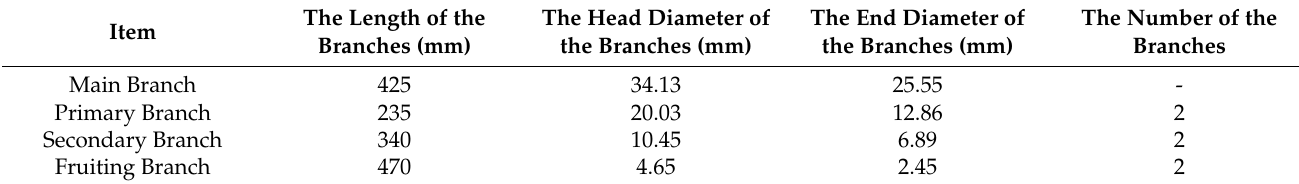
Table 1. The shape parameters of the L. barbarum shrub.